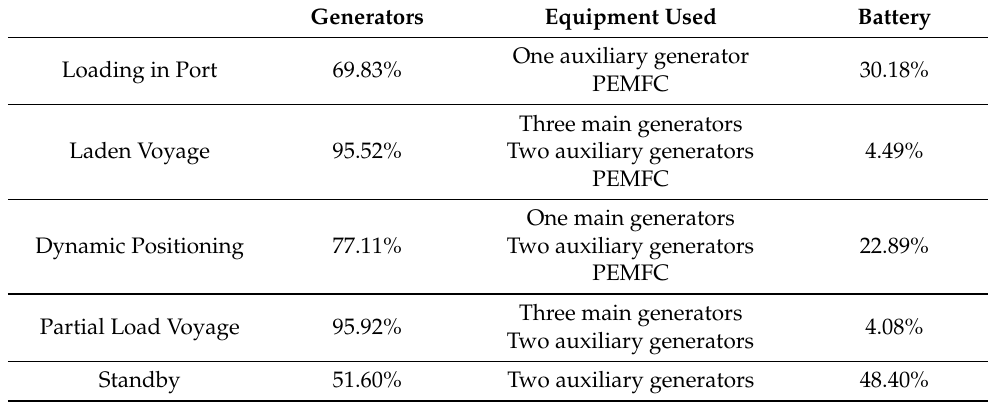
Table 6. Energy contribution in percentages for generators and the batteries that compose the configuration that achieved the highest-emission reduction for a 10% lower